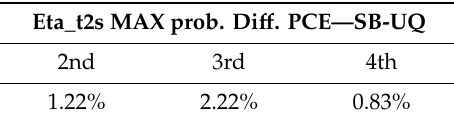
Table 6. Overall efficiency maximum absolute probability differences from SB-UQ approach. Table 6. Overall e ffi ciency maximum absolute probability di ff erences from SB-UQ